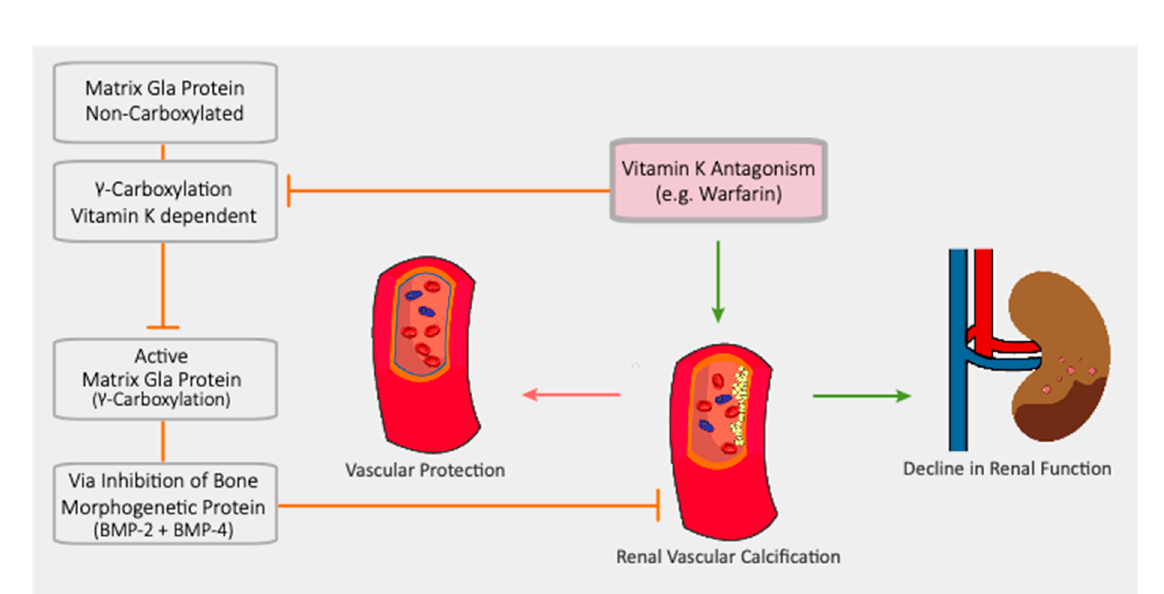
Figure 5. Vascular calcification, arterial and renal damage induced by inhibition of vitamin-K-dependent MGP.